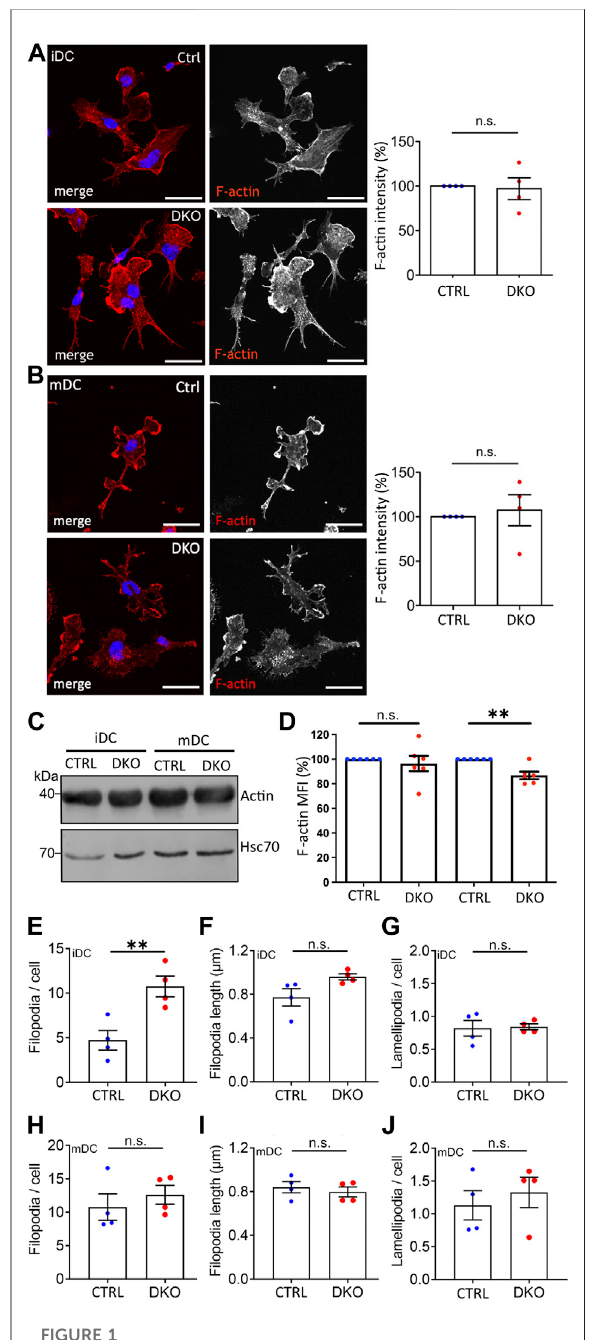
Loss of Evl and VASP results in alterations in F-actin levels and fi lopodia. (A,B) No detectable difference in F-actin localization and level by immuno fl uorescence. Immature (A) and mature (B) control and DKO DCs were processed for immuno fl uorescence and incubated with phalloidin to label F-actin. Nuclei were stained with DAPIandaredepictedinblueinthemergedimages.Scalebar:25 µm. Fluorescence intensities were quanti fi ed and are expressed as % of control levels (depicted as mean ± SEM; statistical analysis by One- sample t -test; N = 4 independent experiments; ns = non signi fi cant). (C) No difference in total actin levels. Lysates from control and DKO